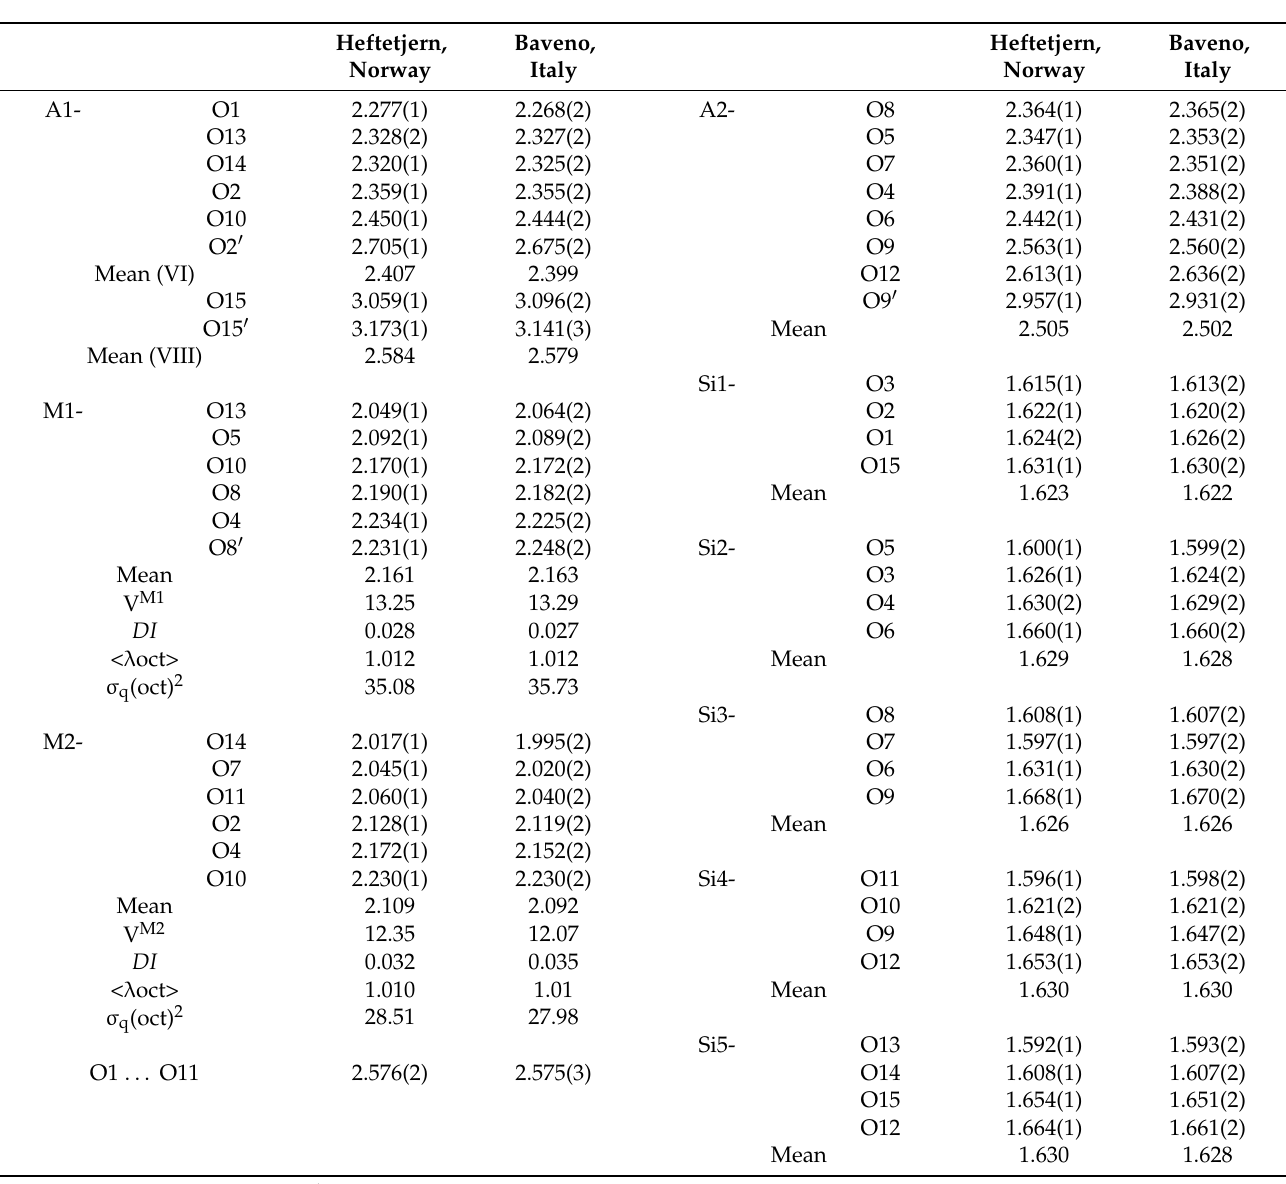
Table 4. Selected bond distances (Å), volumes of polyhedra (Å 3 ) and deformation parameters for octahedra * 1